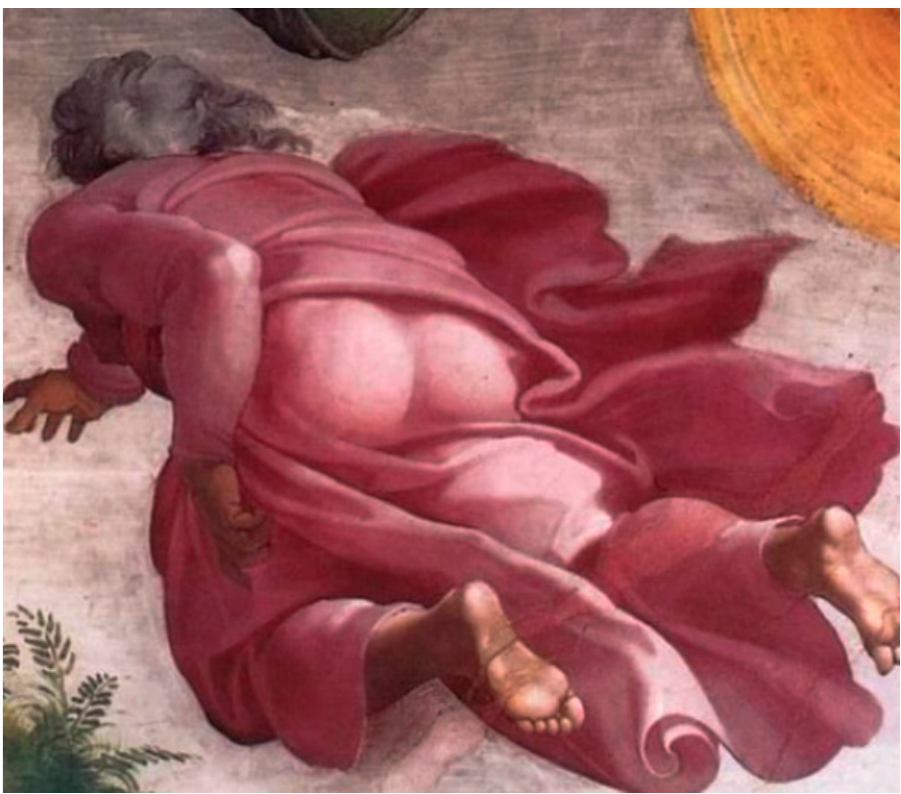
Figure 5. God’s ass after Michelangelo in the Sistine Chapel. A close-up view of a section. Álvarez-Junco (2016) insisted on what transgression in graphic humor means: “the unreal and fantastical world where we have been transferred, nullifying temporarily our